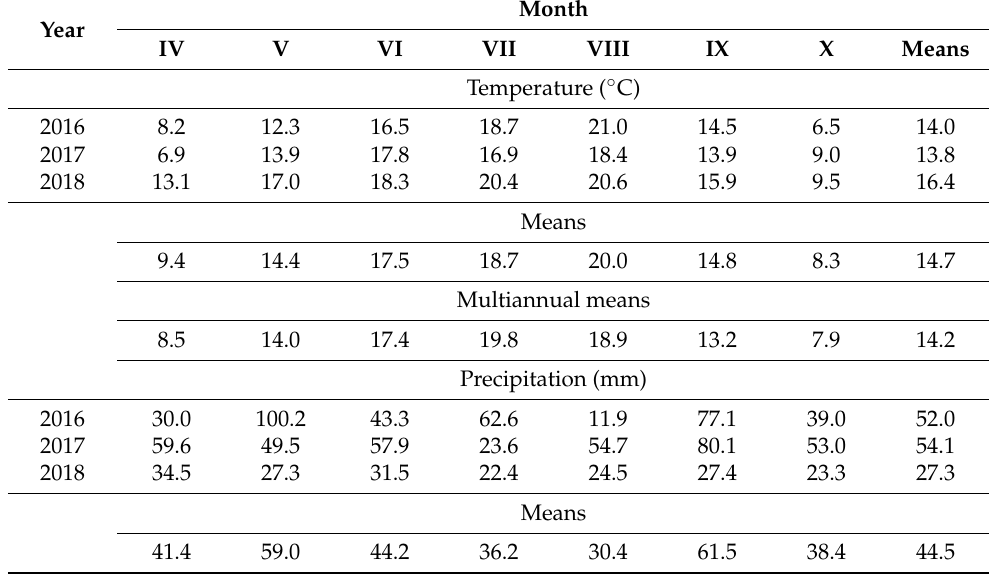
Table 1. Average monthly air temperature ( ◦ C), monthly precipitation (mm) and monthly Sieliani- nov’s coefficient in growing